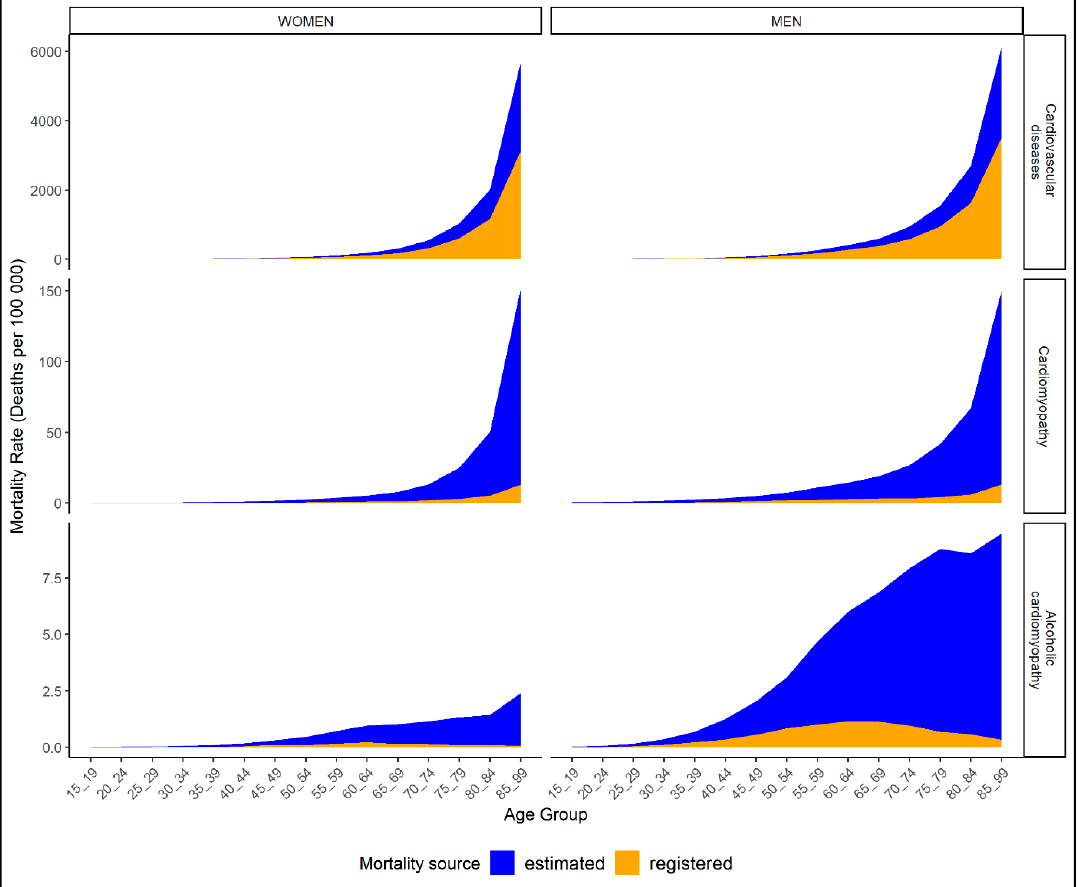
Figure 1. Mortality rates of registered (orange) and estimated (blue) deaths over the life span by cause of death definition (rows) and sex (columns); based on most recent available mortality data from n = 77 countries.